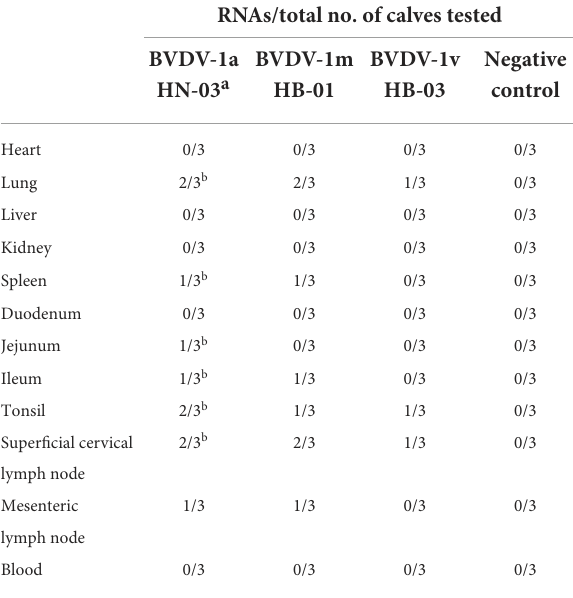
TABLE 3 Viral RNAs were determined by reverse transcription polymerase chain reaction (RT-PCR) in different tissues from euthanized calves at 28 dpi.